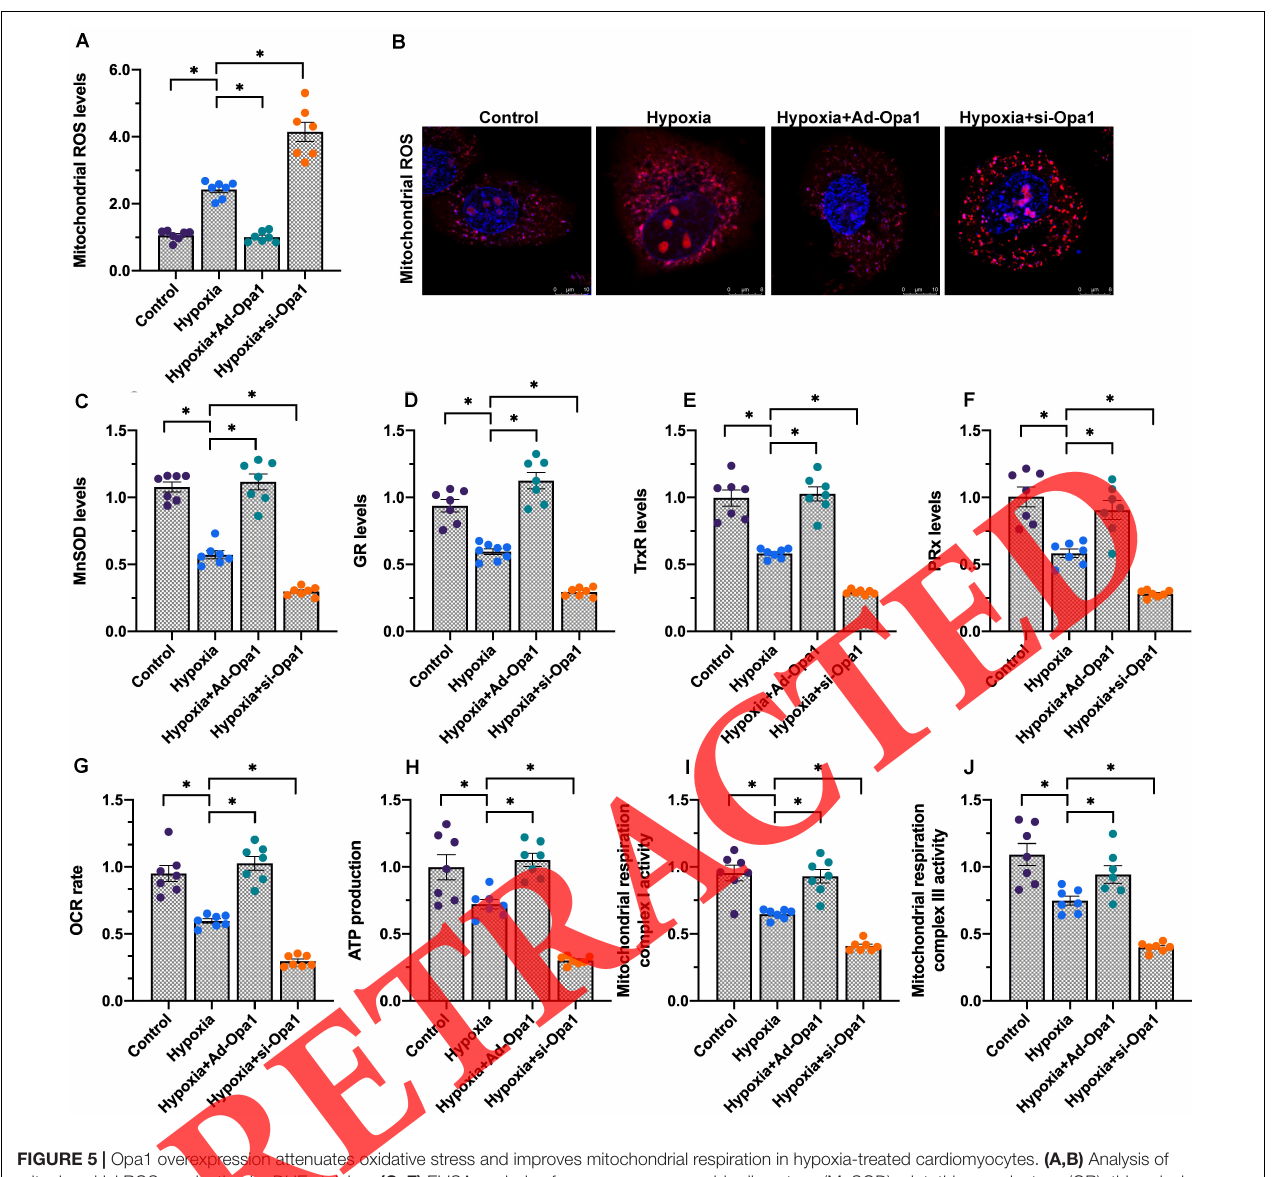
FIGURE 5 | Opa1 overexpression attenuates oxidative stress and improves mitochondrial respiration in hypoxia-treated cardiomyocytes. (A,B) Analysis of mitochondrial ROS production by DHE staining. (C–F) ELISA analysis of manganese superoxide dismutase (MnSOD), glutathione reductase (GR), thioredoxin reductase (TrxR), and peroxiredoxin (PRx) levels in (culture media from) hypoxia-treated cardiomyocytes. (G) Determination of mitochondrial oxygen consumption rate (OCR). (H) Measurement of ATP production in cardiomyocytes subjected to hypoxic stress. (I,J) ELISA/Colorimetric analysis of mitochondrial respiratory complex I and III activities in hypoxia-treated cardiomyocytes. ∗ p <